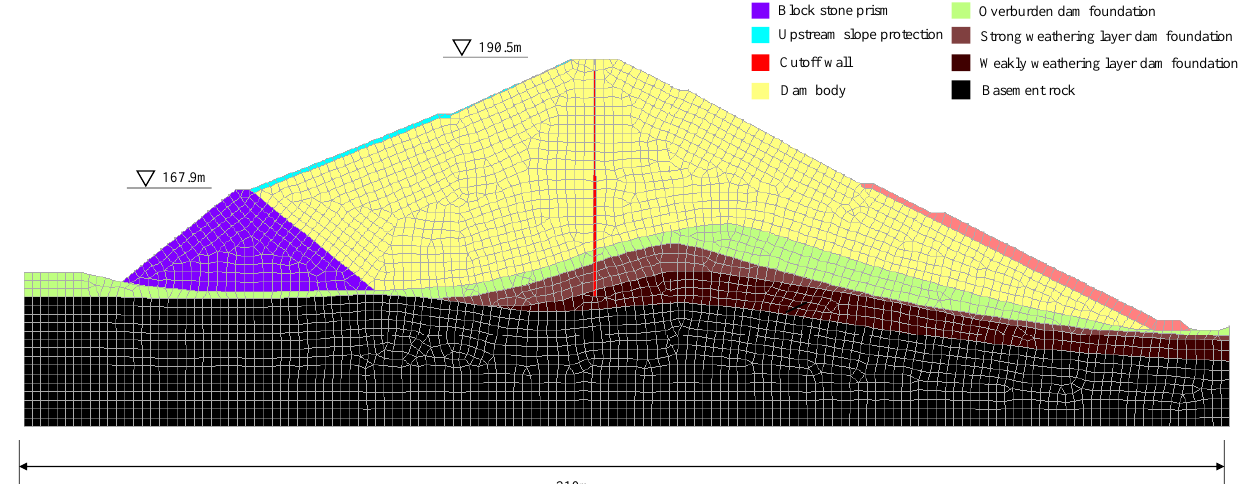
Figure 2. Numerical model of Wujing reservoir dam.